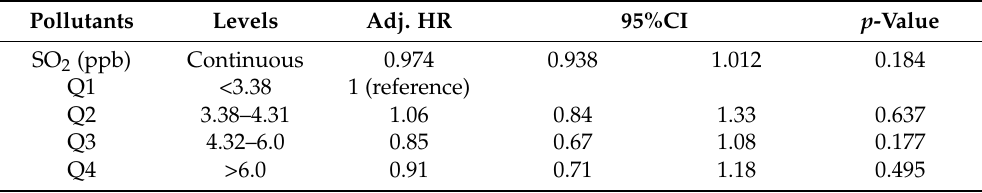
Table 3. Adjusted hazard ratios (aHRs) of BBT in the residents exposed to the highest, 2nd, and 3rd concentrations of air pollutants compared to those exposed to the lowest